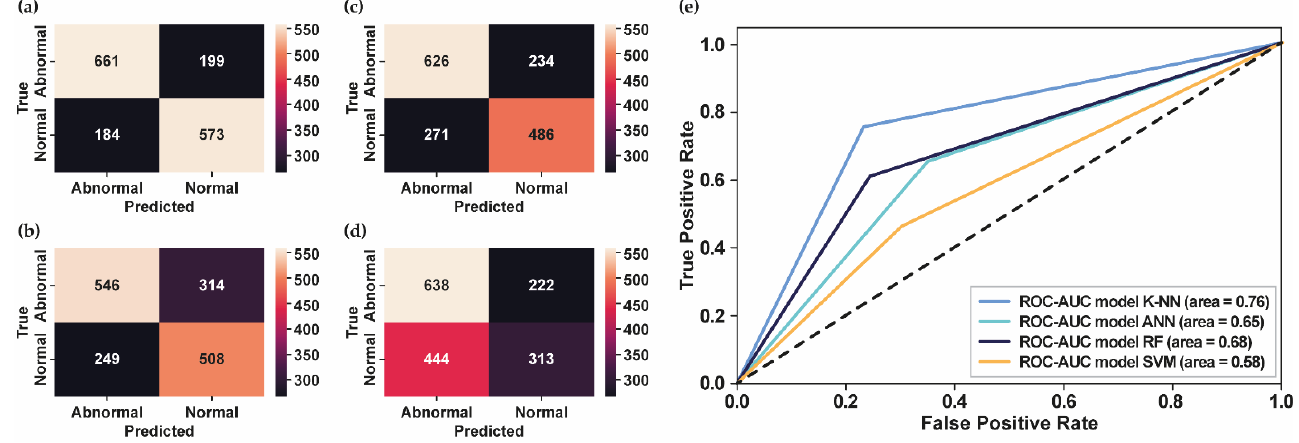
Figure 5. The confusion matrix and the ROC curve for PhysioNet Challenge 2022. ( a ) The confu- sion matrix of test datasets using K-NN; ( b ) The confusion matrix of test datasets using ANN; ( c ) The confusion matrix of test datasets using RF; ( d ) The confusion matrix of test datasets using SVM; ( e ) The ROC curve of several classifier models.